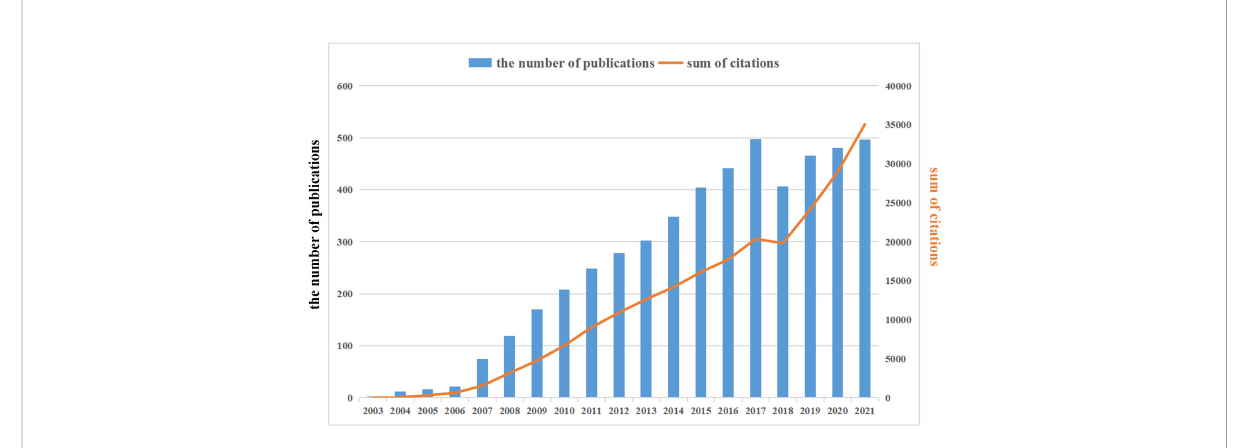
FIGURE 3 The annual publications and citations annual number of publications and citations in the fi eld of glioma stem cells (GSCs) from 2003 to 2021. There is an increasing trend in GSCs.